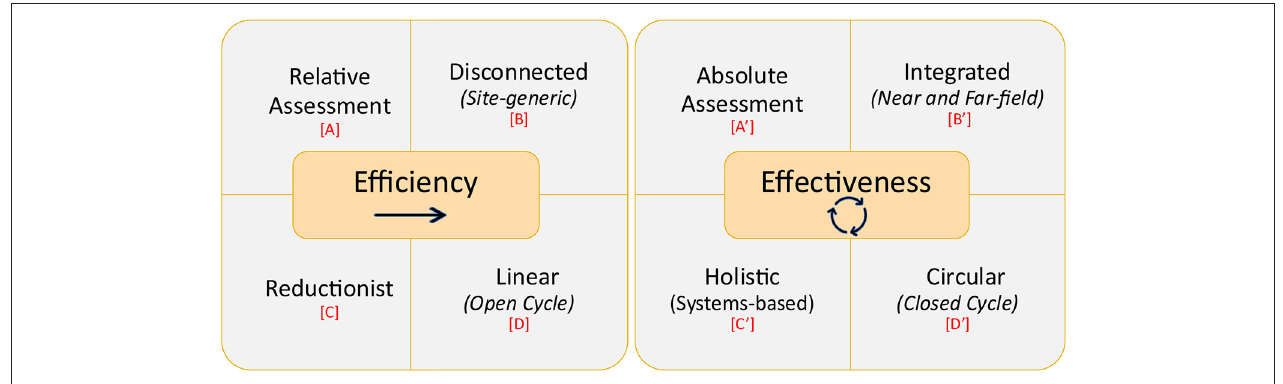
FIGURE 2 | Contextualizing efficiency and effectiveness for sustainability assessment, adapted from (Kumar and Mani,